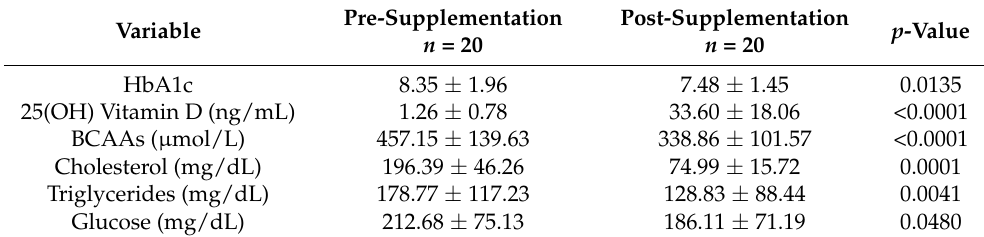
Table 3. Vitamin D